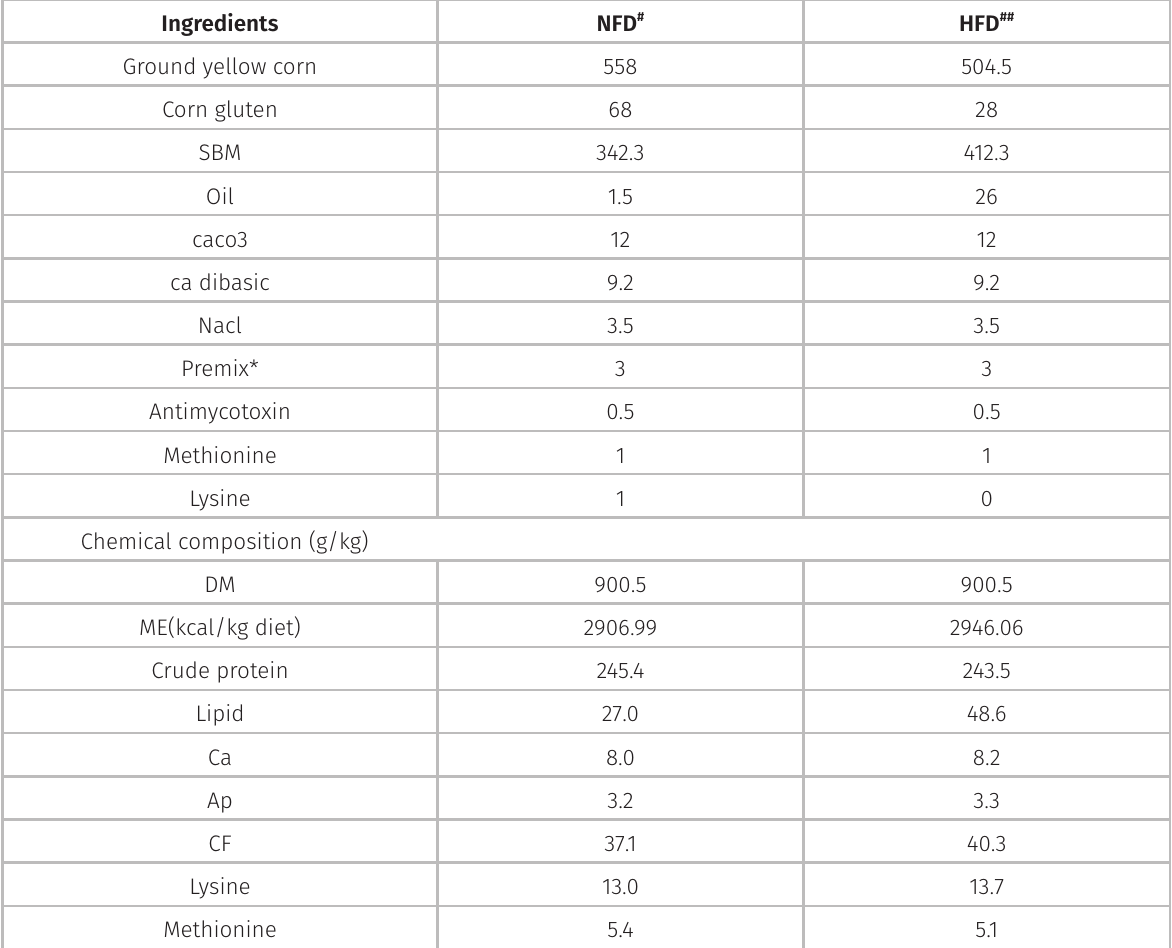
Table I. Ingredients and proximate composition of the experimental diets.